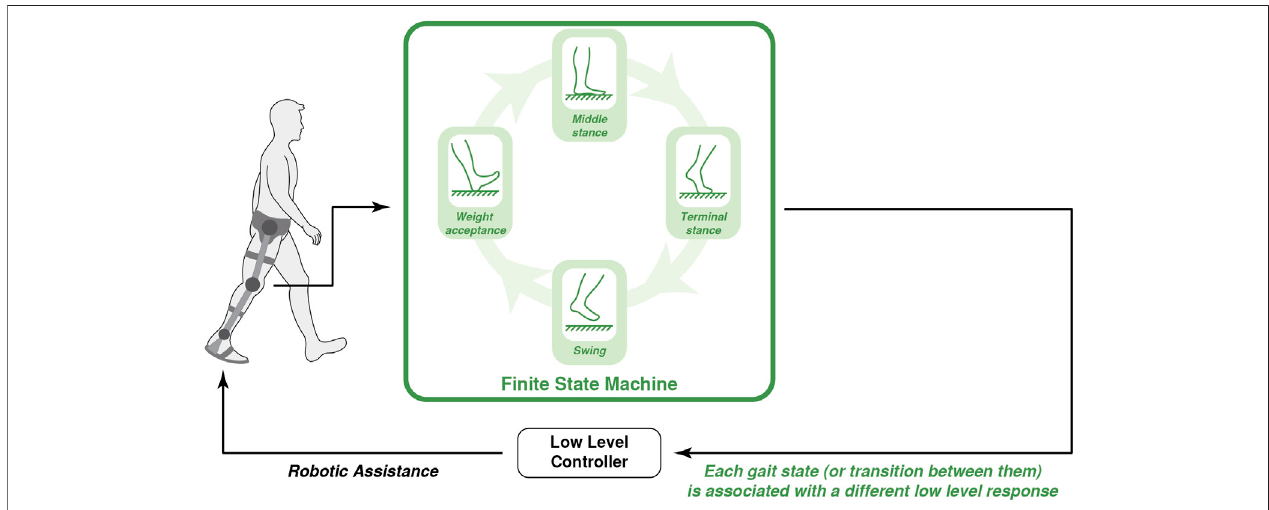
FIGURE 3 | Conceptual representation of the robot-gait coordination based on a fi nite state machine: each gait state or the transitions between them are associated to a different action in the exoskeleton.